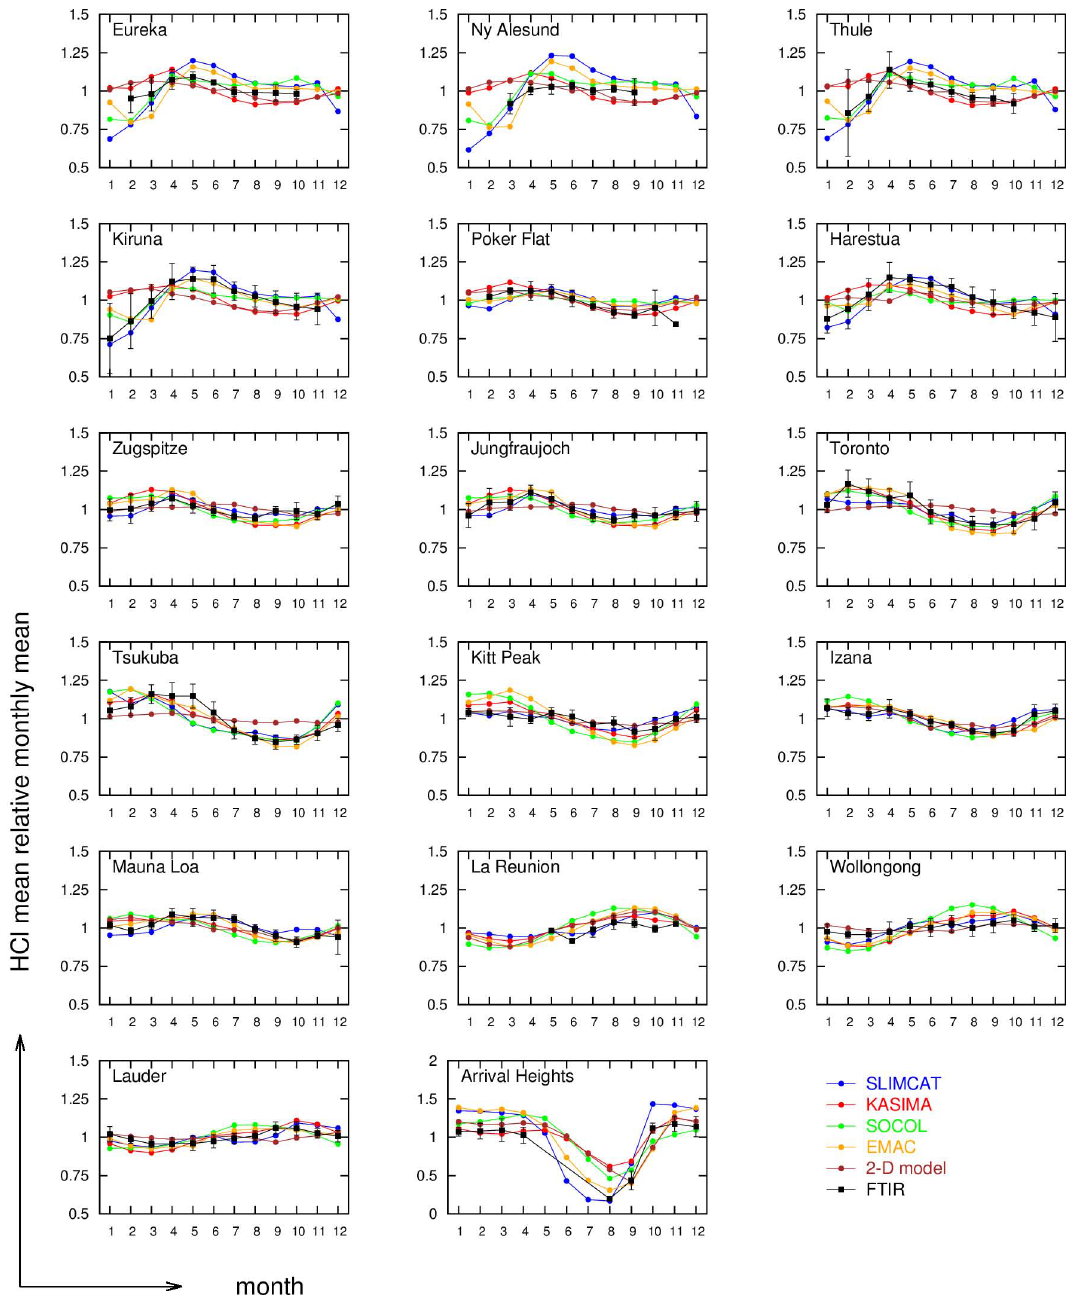
Fig. 6. Annual cycle of HCl at the different sites as determined from the FTIR instruments (black) and simulated by SLIMCAT (blue), KASIMA (red), SOCOL (green), EMAC (orange), and the Bremen 2-D model (brown). The mean relative monthly means were calculated by normalising the monthly means with the respective annual mean and then averaging over the period 2000–2009. The error bars of the FTIR measurements represent the standard